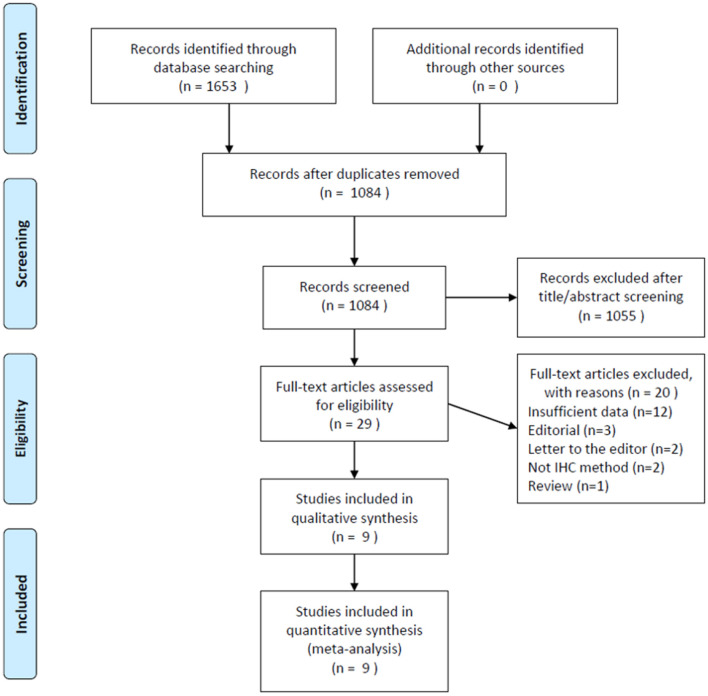
The literature search process.